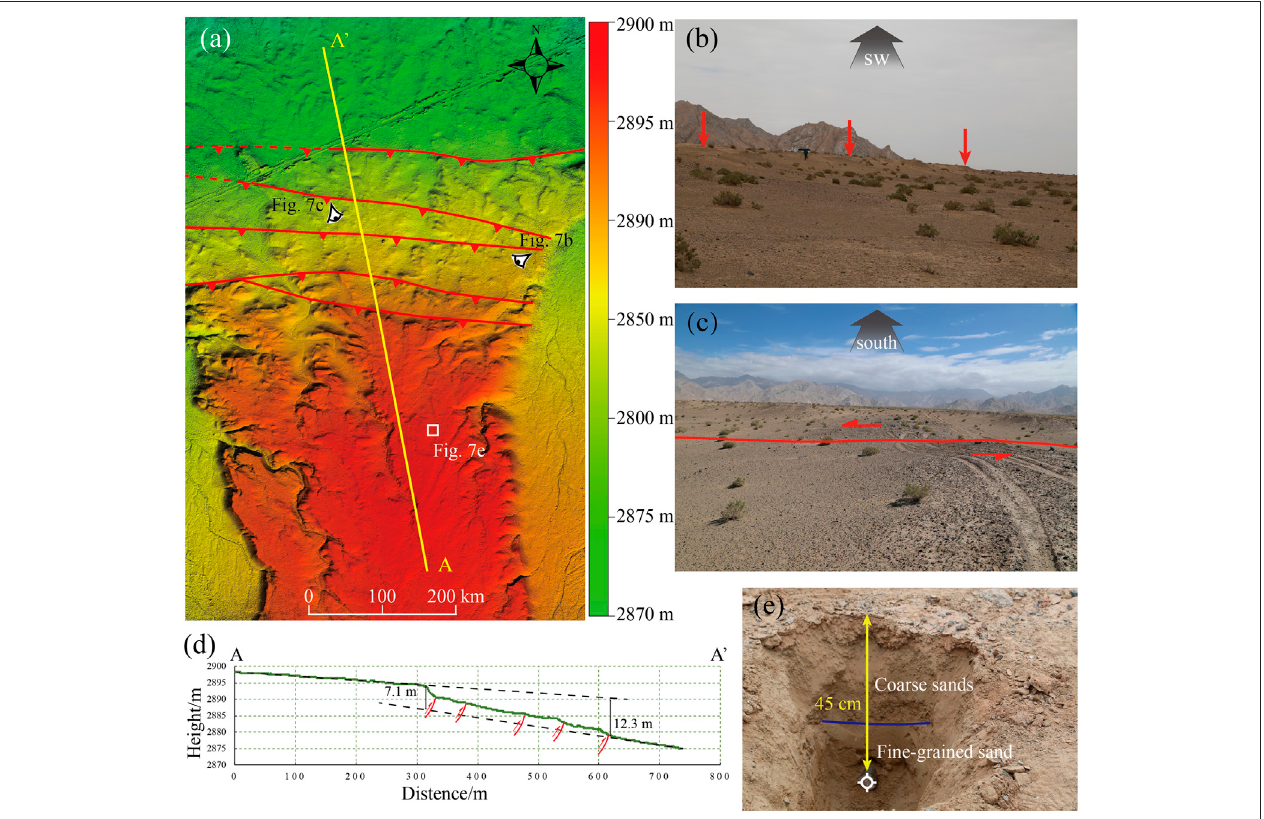
FIGURE 7 | (A) DEM data at the Hongliugou Site. A-A ’ represent the location of topographic pro fi les in Figure 7D . (B,C) Field photos of scarp and left-laterally offset gully. Red arrows and bold line represent the active fault traces. (D) Topographic pro fi les extracted from DEM data used to measure the scarp height. (E) OSL sampling photo. Sample site is shown in Figure 4A